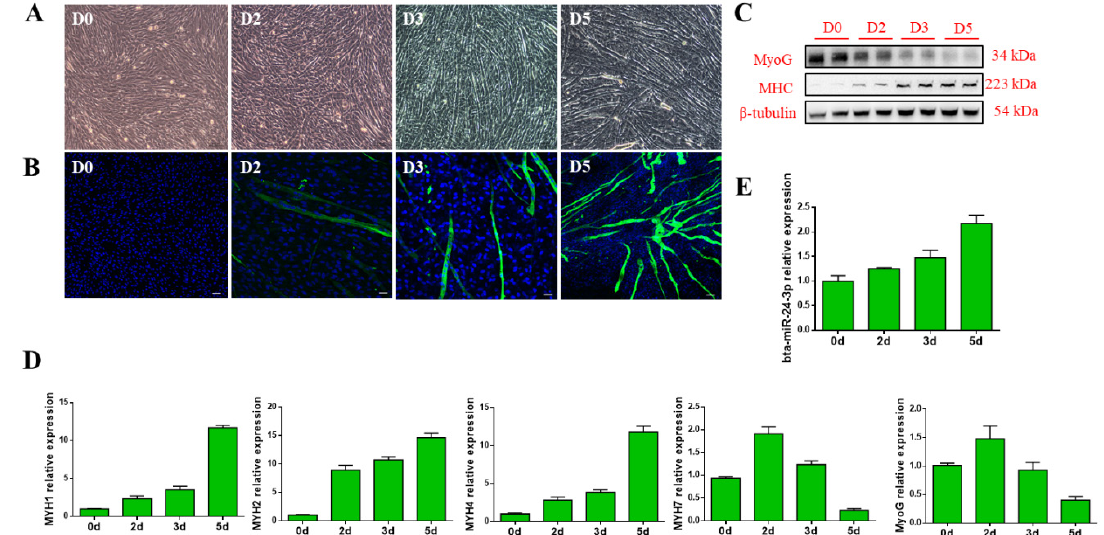
Figure 1 . bta-miR-24-3p expression during the myogenic differentiation of platelet-derived growth factor receptor alpha (PDGFR α -) progenitor cells. ( A ) Microscopic images of bovine PDGFR α - progenitor cells on days 0, 2, 3, and 5 (D0, D2, D3, and D5, respectively) of differentiation. Scale bars = 100 μ m. ( B ) Myosin heavy chain (MHC)-positive cells (green) on D0, D2, D3, and D5 of myogenic differentiation, visualized by immunofluorescence; scale bars = 100 μ m. ( C ) Western blot evaluating the protein levels of myogenin and MHCs in cells cultured, as described in A. ( D ) Transcript levels of myogenin and MHCs in cells cultured, as described in (A). ( E ) The transcript level of bta-miR-24-3p in cells cultured, as described in (A). All data are represented as mean ± standard deviation (SD), based on at least three independent experiments for each treatment.